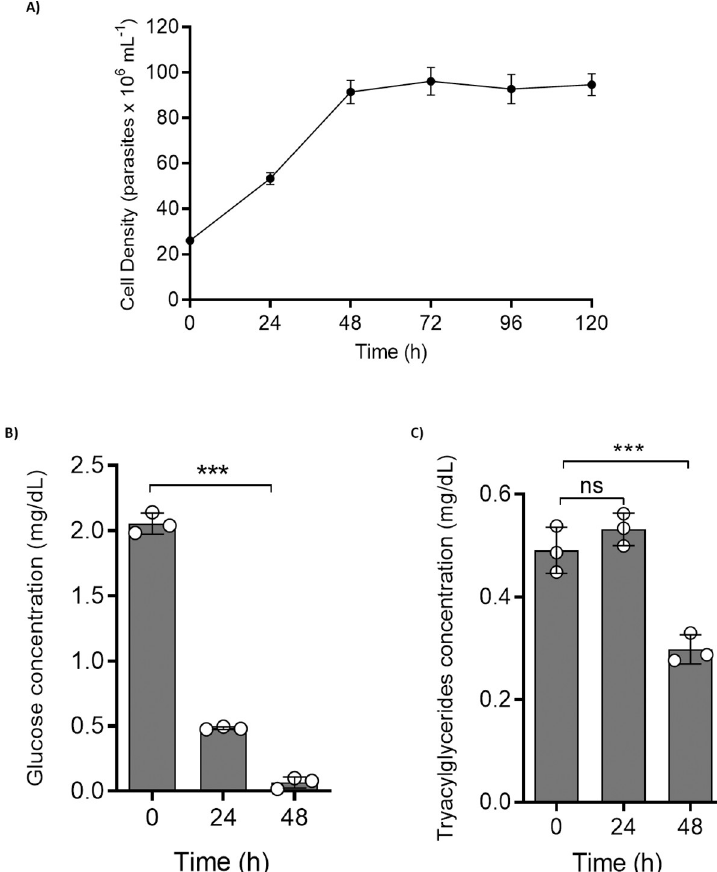
Fig 3. Changes in glucose and triacylglycerol contents in LIT medium. A) Growth curve of epimastigote forms. B) Glucose quantification over 48 h. C) Triacylglycerol levels over 48 h. In each experiment, we collected each medium at different times and subjected it to quantification according to the manufacturer’s instructions. All the experiments were performed in triplicates. Statistical analysis was performed with one-way ANOVA followed by Tukey’s post-test p < 0.05 using the GraphPad Prism 8.0.2 software program. We represent the levels of statistical significance in this figure as follows: ��� p value < 0.001; �� p value < 0.01; and � p value < 0.05. For p value > 0.05, we consider the differences not significant